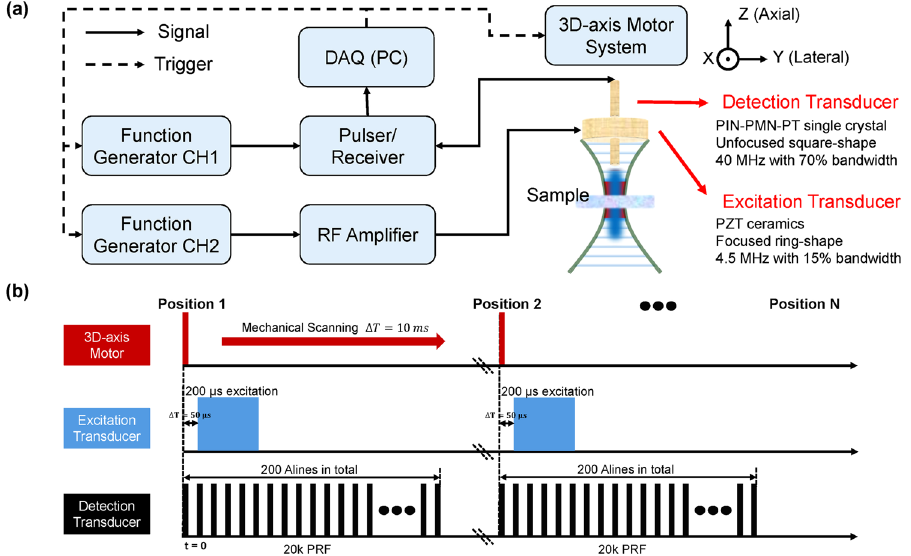
Figure 6. Schematic diagram of the designed multi-functional ultrasonic micro-elastography imaging system. ( a ) The experimental setup and transducer parameters. ( b ) The synchronized timing sequence controlled by multi-functional ultrasonic micro-elastography imaging